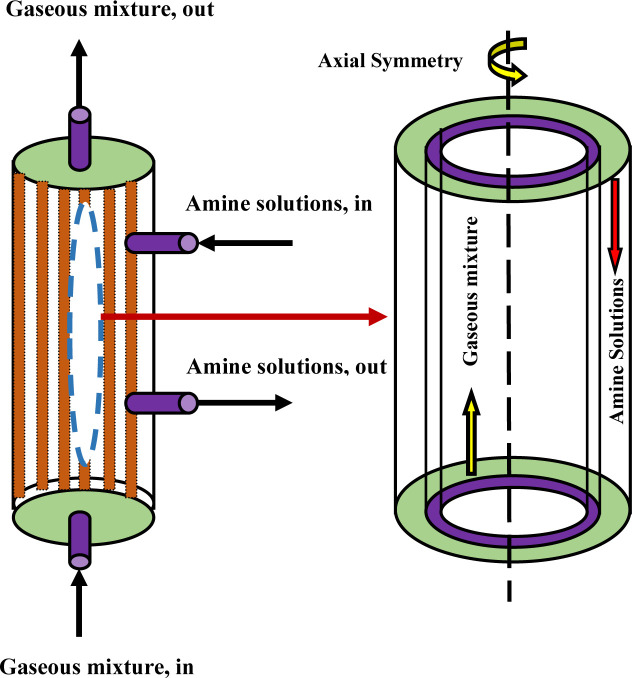
The representation of hydrophobic HFMC.